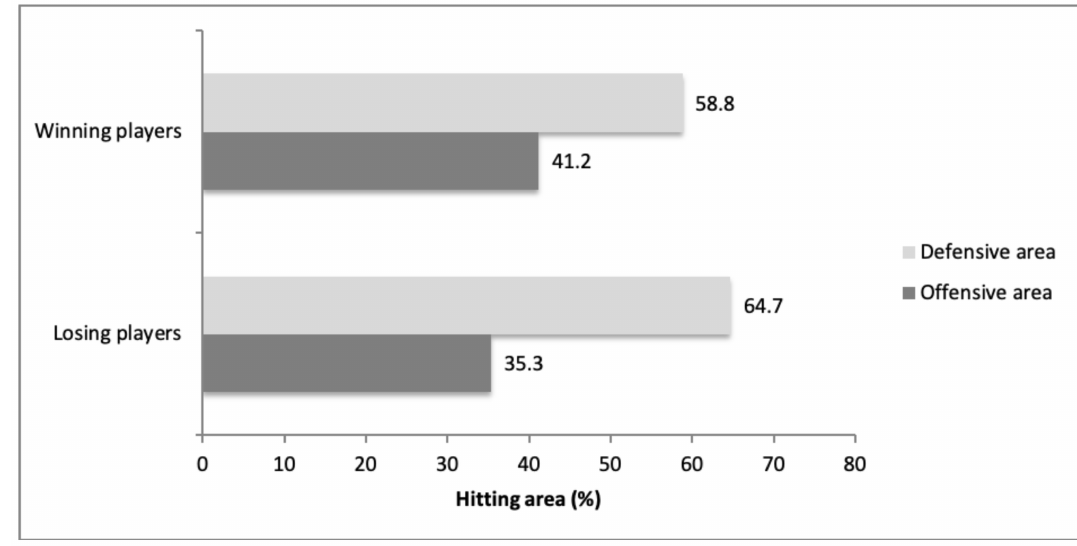
Figure 2. Distribution of the percentage of defensive and o ff ensive shots performed by the winning and losing